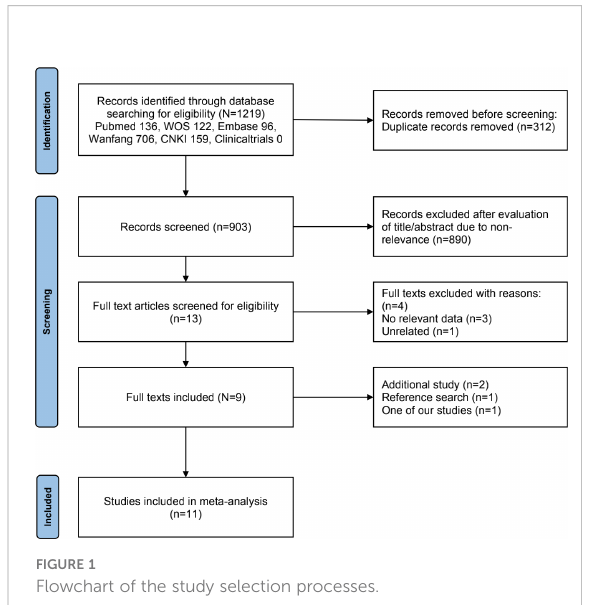
FIGURE 1 Flowchart of the study selection